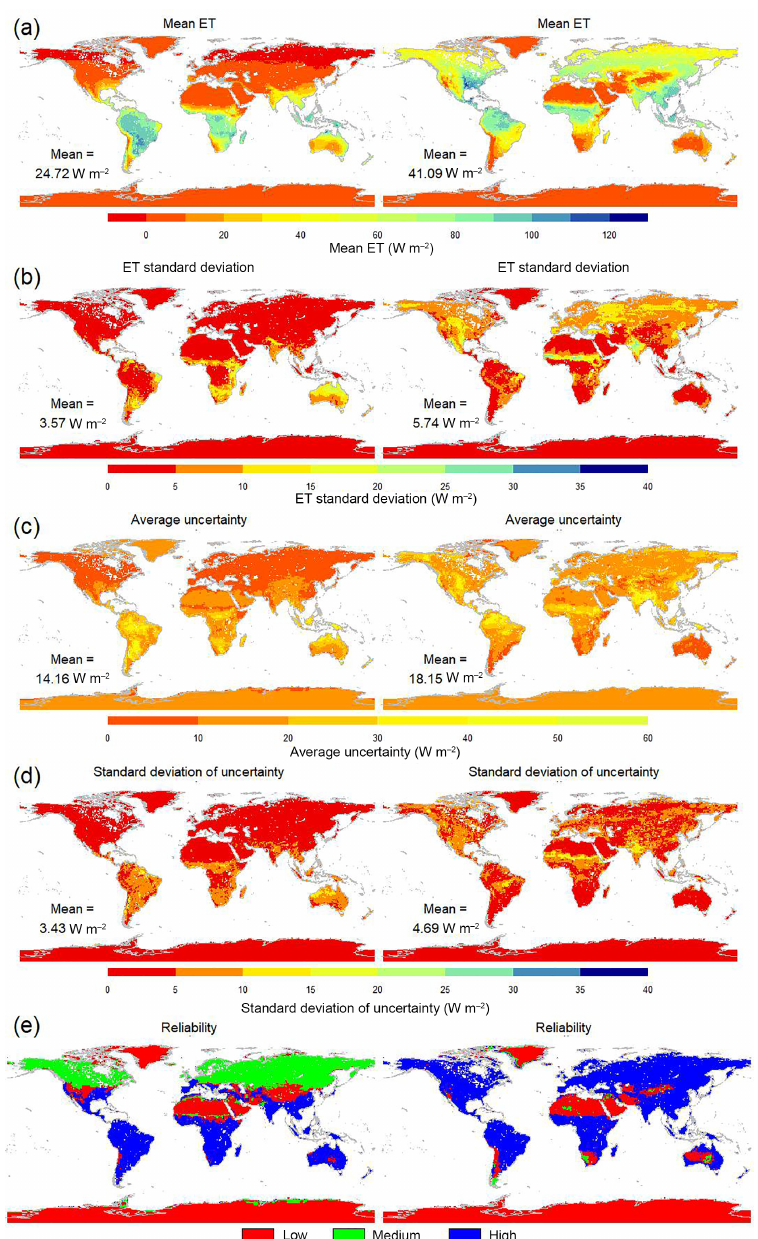
q σ 2 e shown in Eq. 11); ≤ 1 in blue), medium ( | mean ET | ≤ 5, uncertainty SD < 10 mean ET